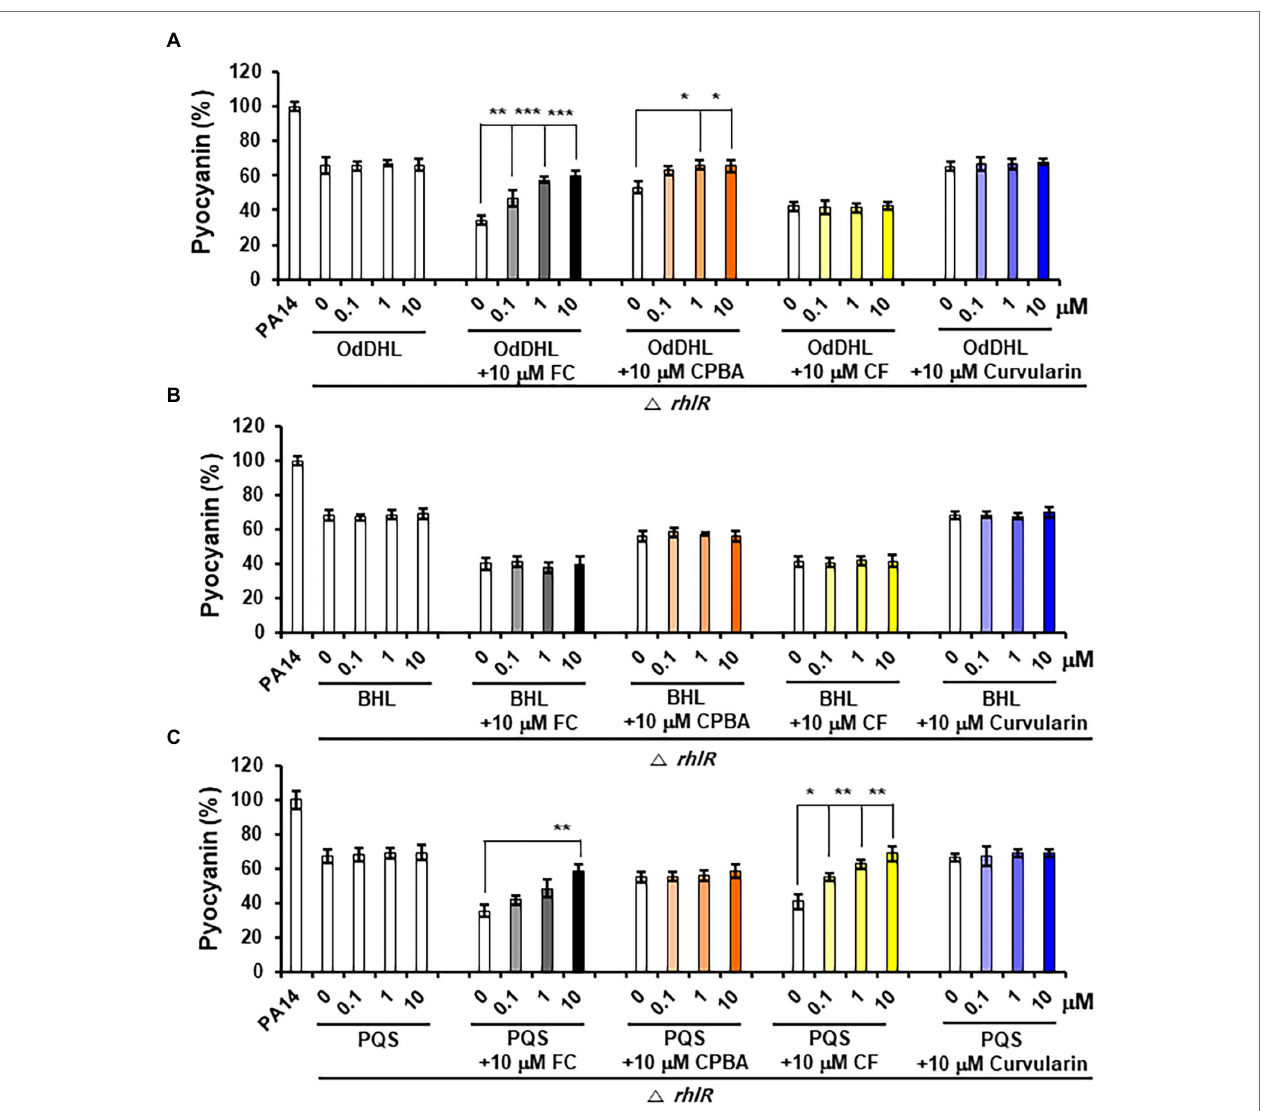
FIGURE 7 | Effects of exogenous QS ligands on curvularin-mediated inhibition of pyocyanin production in the Δ rhlR mutant. Pyocyanin production in the Δ rhlR mutant cultured with curvularin (10 μ M) in the presence or absence of different concentrations of OdDHL (A) , BHL (B) , or PQS (C) for 18 h. FC, CPBA, and CF are known antagonists of LasR, RhlR, and PqsR, respectively. The data are representative of three independent experiments performed in triplicate and expressed as the mean ± SD values in each bar. * p < 0.01; ** p < 0.001; and *** p < 0.0001 versus DMSO